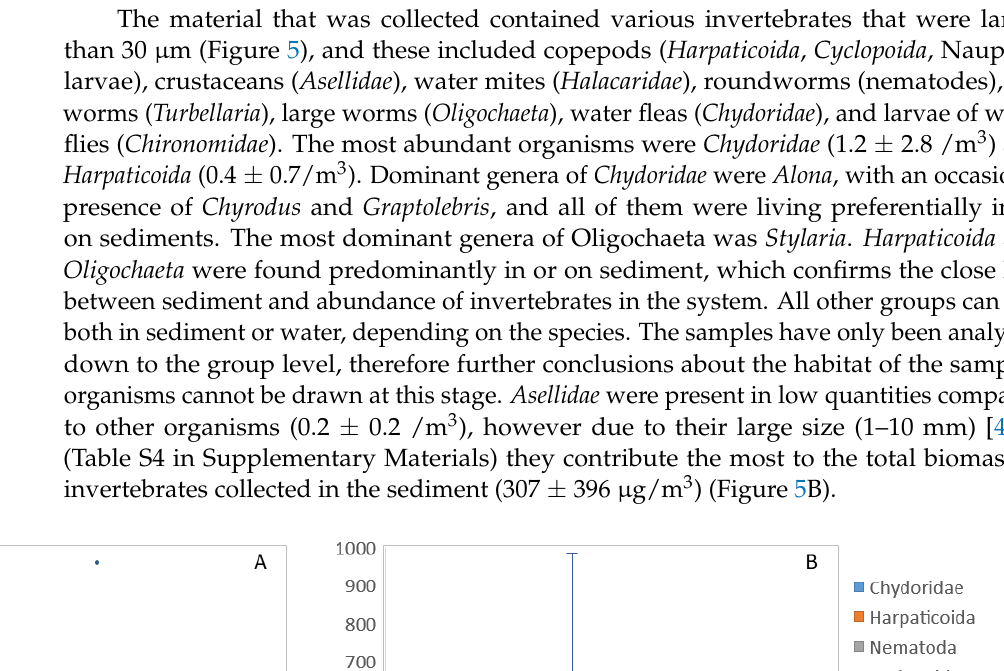
Figure 4. Variations over six years of the sediment volume, water temperature, biomass of inverte- brates (>30 µm), and Aeromonas at location E1 of the study system. Sediment was collected in filters in place for one to two weeks (Table 1), and the sediment volumes and biomass of invertebrates were normalized to a cubic meter of filtered water. Aeromonas data in the period March to August 2020 are not available.